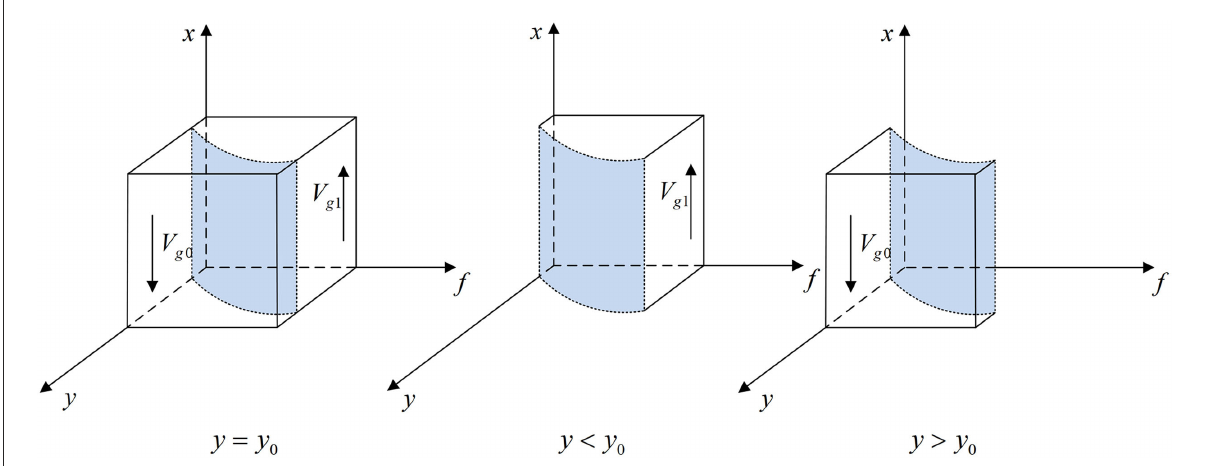
FIGURE2 Phase diagram of the government regulator’s strategic choice. Figure is the phase diagram that shows the evolutionary trend of government regulator’s strategy obtained by calculating the response function of the probability of government regulator choosing the “strict supervision”